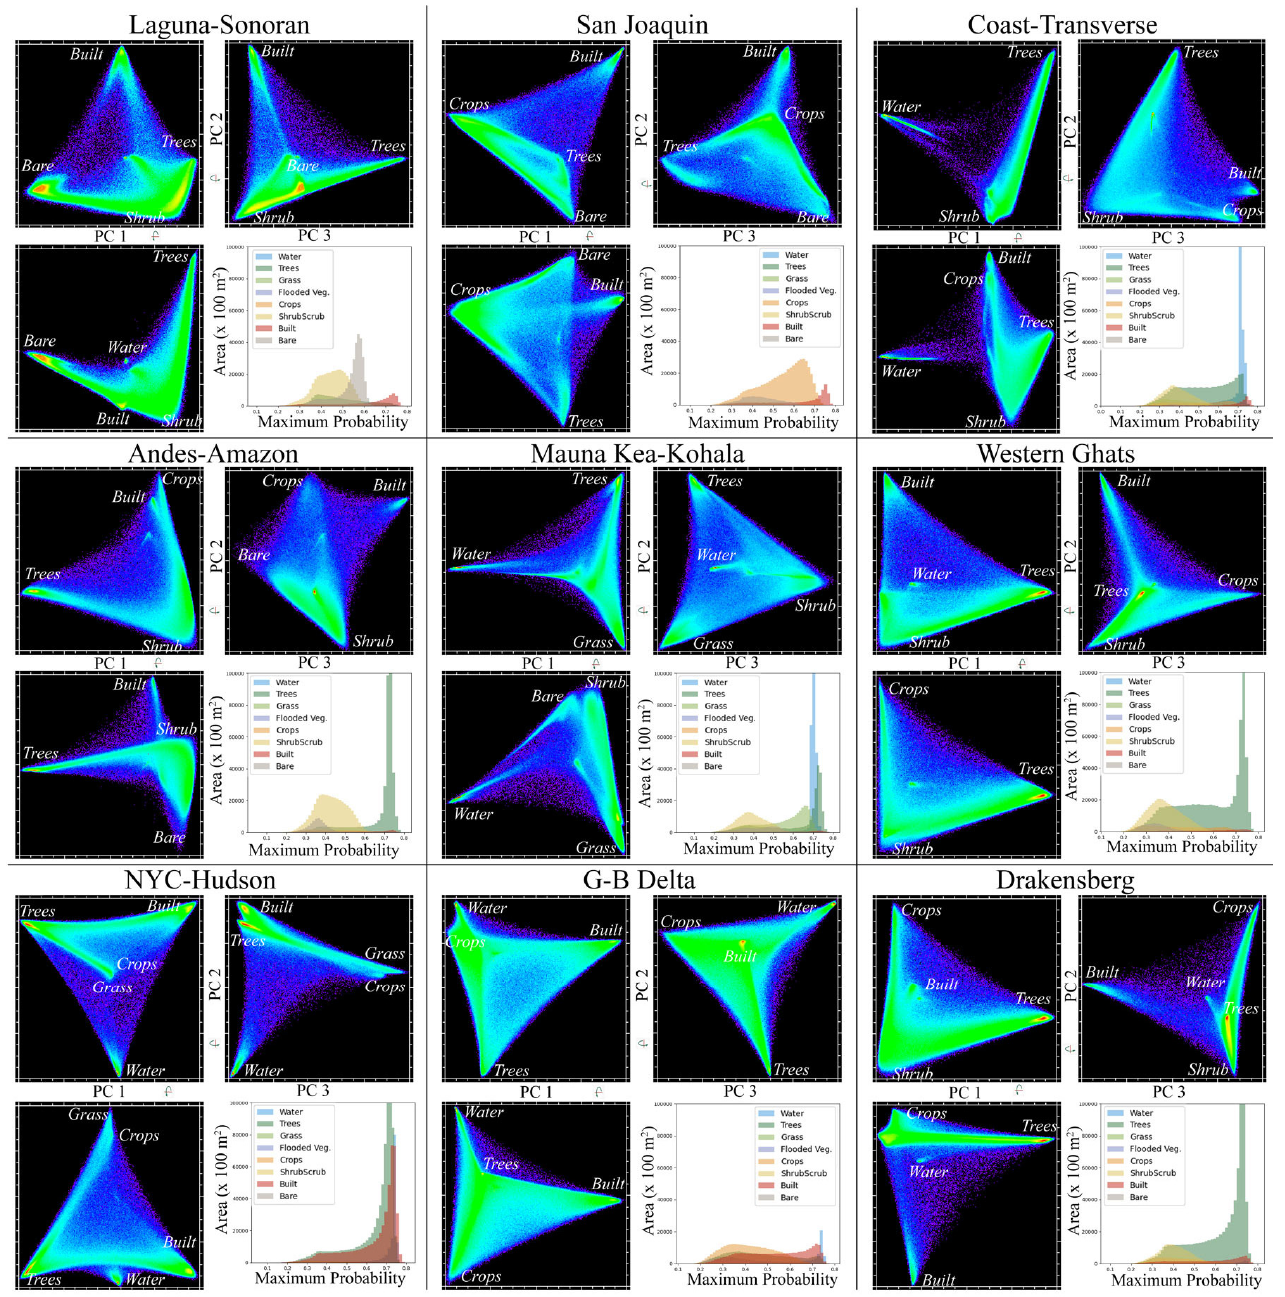
Figure 5. Class probability feature spaces for nine spectral diversity hotspots. Orthogonal projections of low-order principal component distributions form 3D feature spaces illustrating continuous probability distributions among discrete classes. Maximum probability distributions (class histograms) show a combination of strongly skewed classes with modes near 0.7 with long lower tails (e.g., Trees) and less skewed distributions with modes <0.5 (e.g., Shrub). The NYC-Hudson and G-B Delta hotspots illustrate the extremes between more clustered and more continuous feature spaces, respectively. Density-shading of the feature spaces uses the same cool to warm color table as Figures 2 and 3. Probability histograms range from 0 to 0.8 in probability and 0 to 10 6 pixels in area.